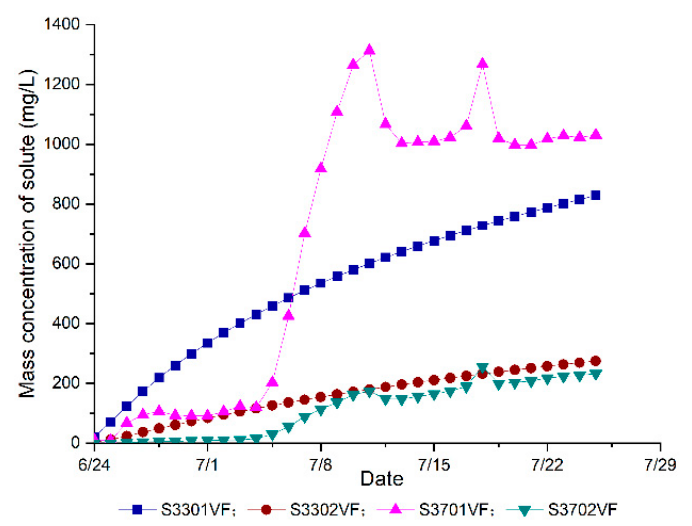
Figure 11. Mass change chart of solute concentration in unit 3501.